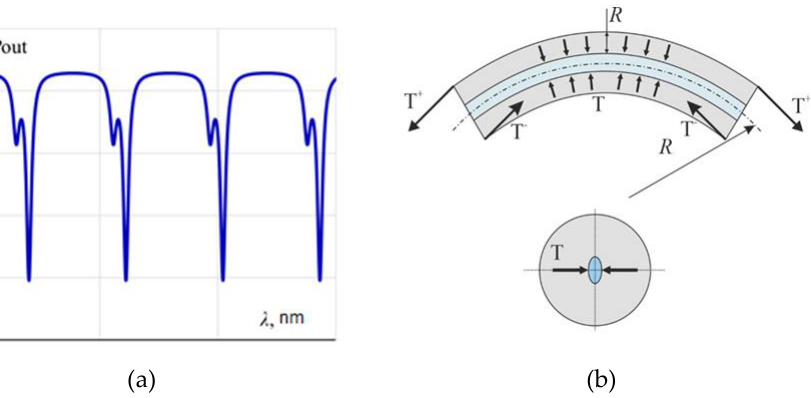
Figure 7. ( a ) Resonance spectrum for induced birefringence in the resonator contour and ( b ) core Figure 7. (a) Resonance spectrum for induced birefringence in the resonator contour and compression caused by bending (b) core compression caused by bending deformation.